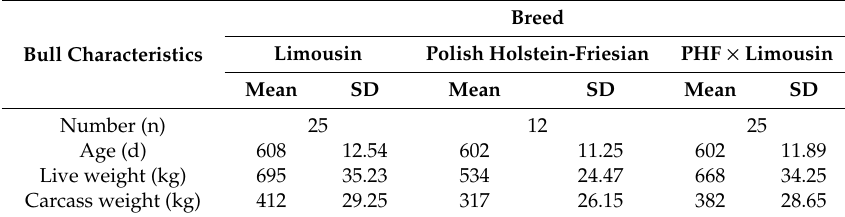
Table 1. Bull characteristics on the day of slaughter.